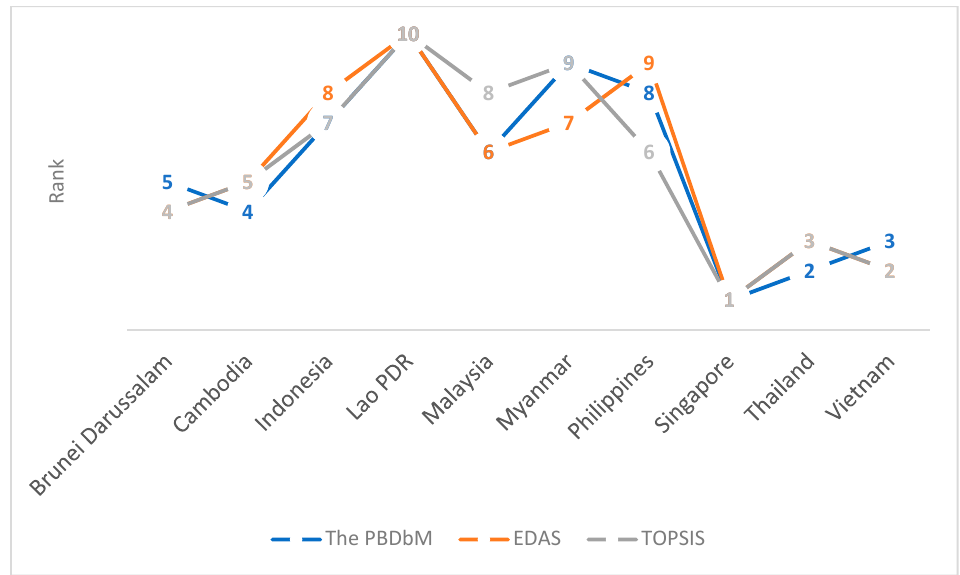
Figure 8. Ranking result comparison.